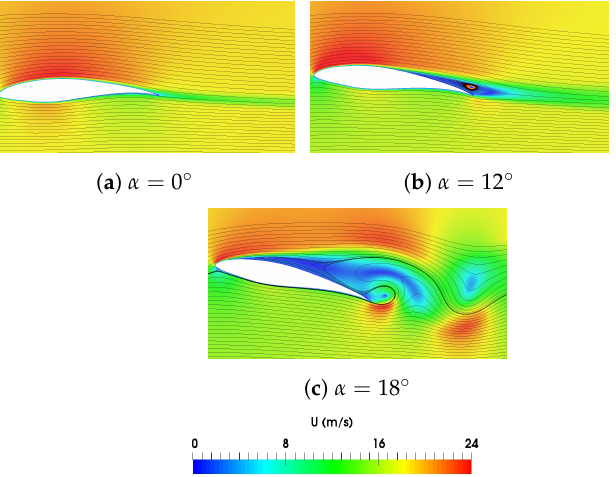
Figure 6. HAWT–S826: Comparison of flow-patterns of the velocity contour (with superimposed streamlines) at α of 0 ◦ , 12 ◦ and 18 ◦ . The streamlines depict the attached, mildly separated and stall regions. At α of 0 ◦ , the flow is symmetrical and streamlined; however, at the critical point α of 12 ◦ , a notable rise in the periodic oscillations is observed and an increase beyond this point started strong flow separation with the generation of the von-Karman vortex street in the wake region. Table 2. HAWT–S826: Angle of attack ( α ) and chord computed over the radial direction along with the error in C d and C l for 2D/2.5D geometric approximations, compared to the 3D geometry. The 2D approximation shows a significant error of 25% at the trailing edge, reported in Figure 7, which is reduced as we move down to the leading edge of blade. The 2.5D simulation on the other hand shows improved performance at the leading edge, but the performance drops to 24.42% at the 0.2 m radial direction of the blade. However, it recovers quickly when moving towards the trailing